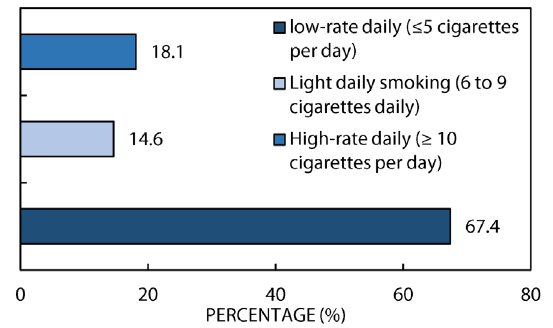
Figure 2: Smoking categories of participants.